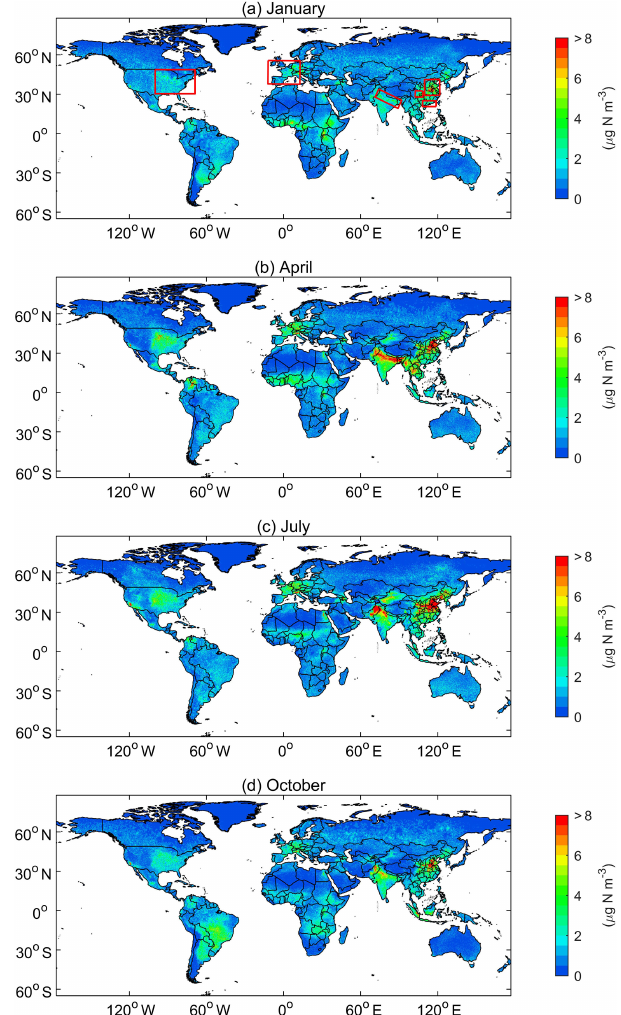
Figure 6. Global surface NH 3 concentrations in January, April, July and October in 2014. The red rectangular regions include eastern China (ECH), Sichuan and Chongqing (SCH), Guangdong (GD), northeastern India (NEI), the eastern US (EUS), and western Europe